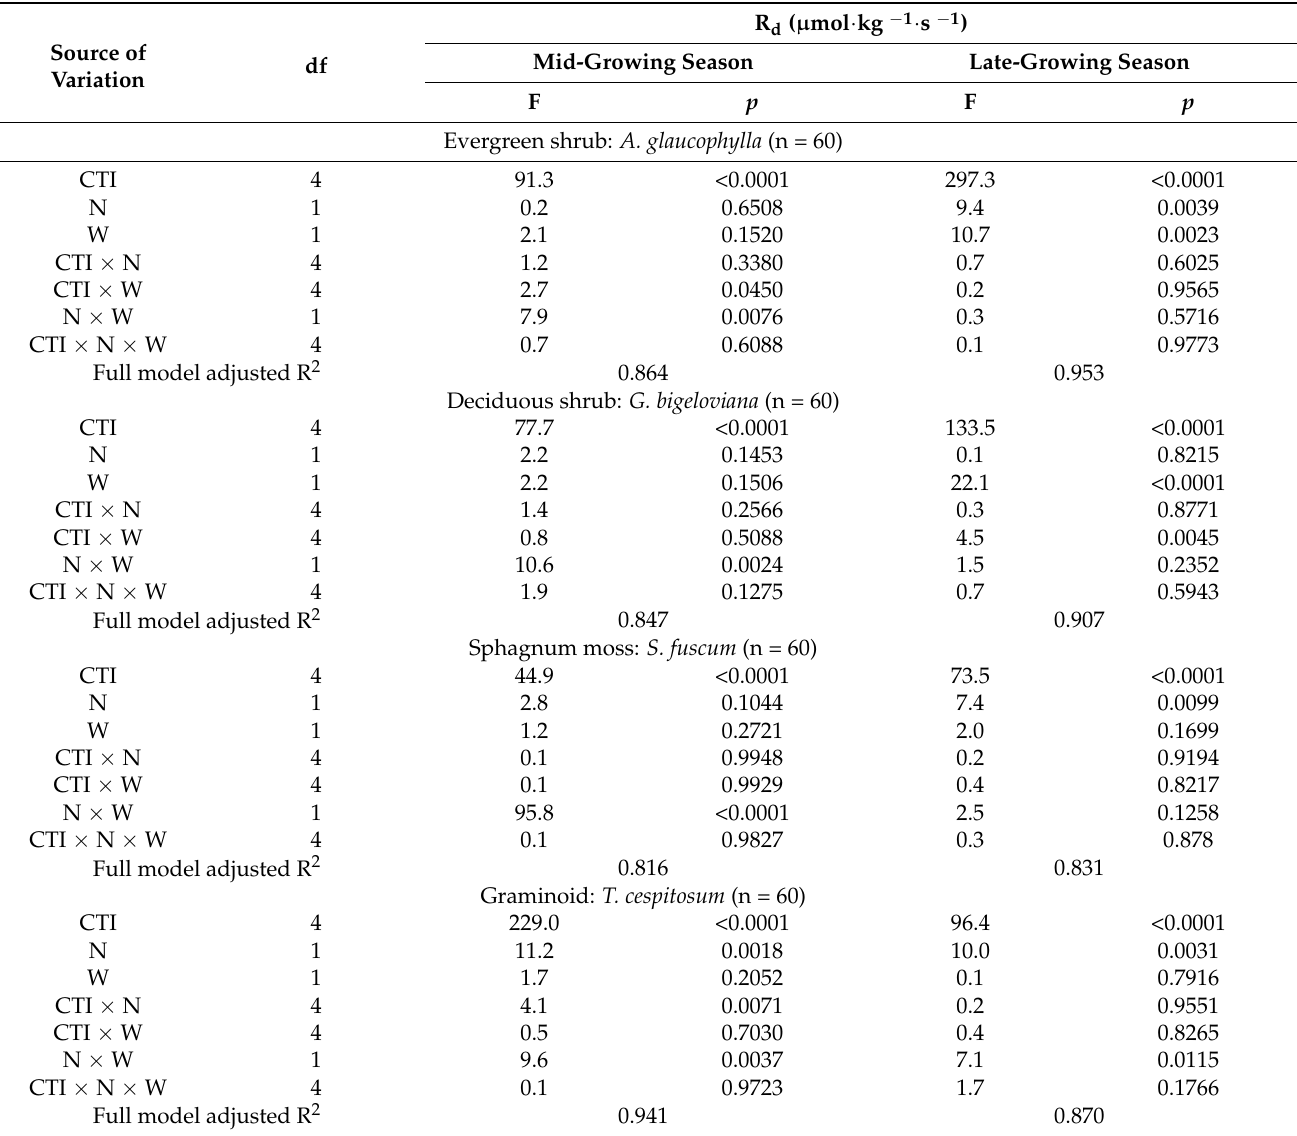
Table 1. Summary of models of both CO 2 and temperature increments (CTI), warming treatment (W) and N fertilizer addition (N), and their combined effects on dark foliar respiration (R d ) in four dominant plant species during the mid-and late-growing season at a boreal